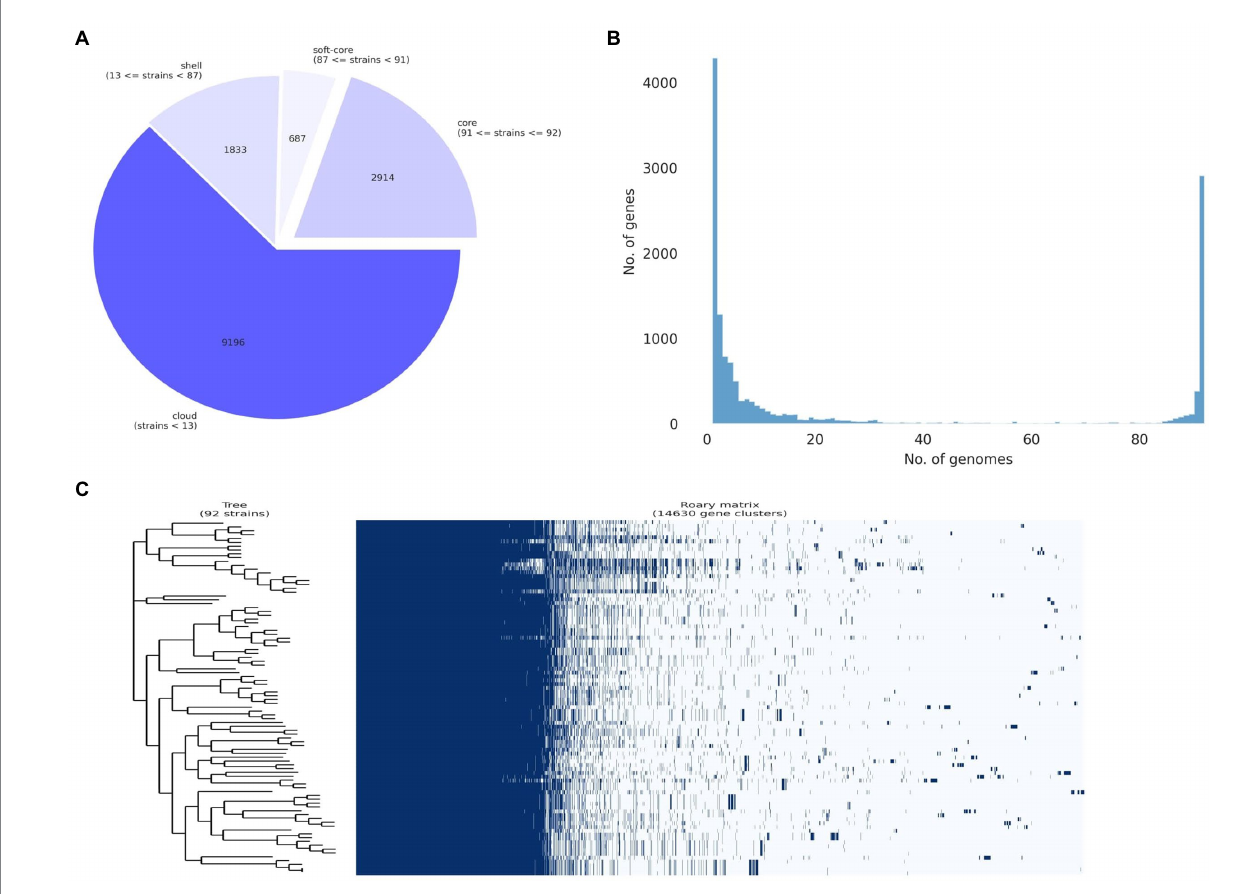
FIGURE 3 Pan-genome analysis of 92 Pantoea ananatis genomes. (A) Pie chart representation of pan-genome composition of P. ananatis . The core genome consists of 2,914 genes, the soft core 687 genes, the shell 1833 genes, and the cloud 9,196 genes for a total of 14,630 genes; (B) distribution of gene (cluster) sizes as a function of the number of genomes they contain displaying the partition of pan-genomic matrix into shell, cloud, soft-core and core compartments using ROARY outputs; and (C) pan-genome gene presence and absence matrix for 92 P. ananatis genomes and associated phylogeny of core gene